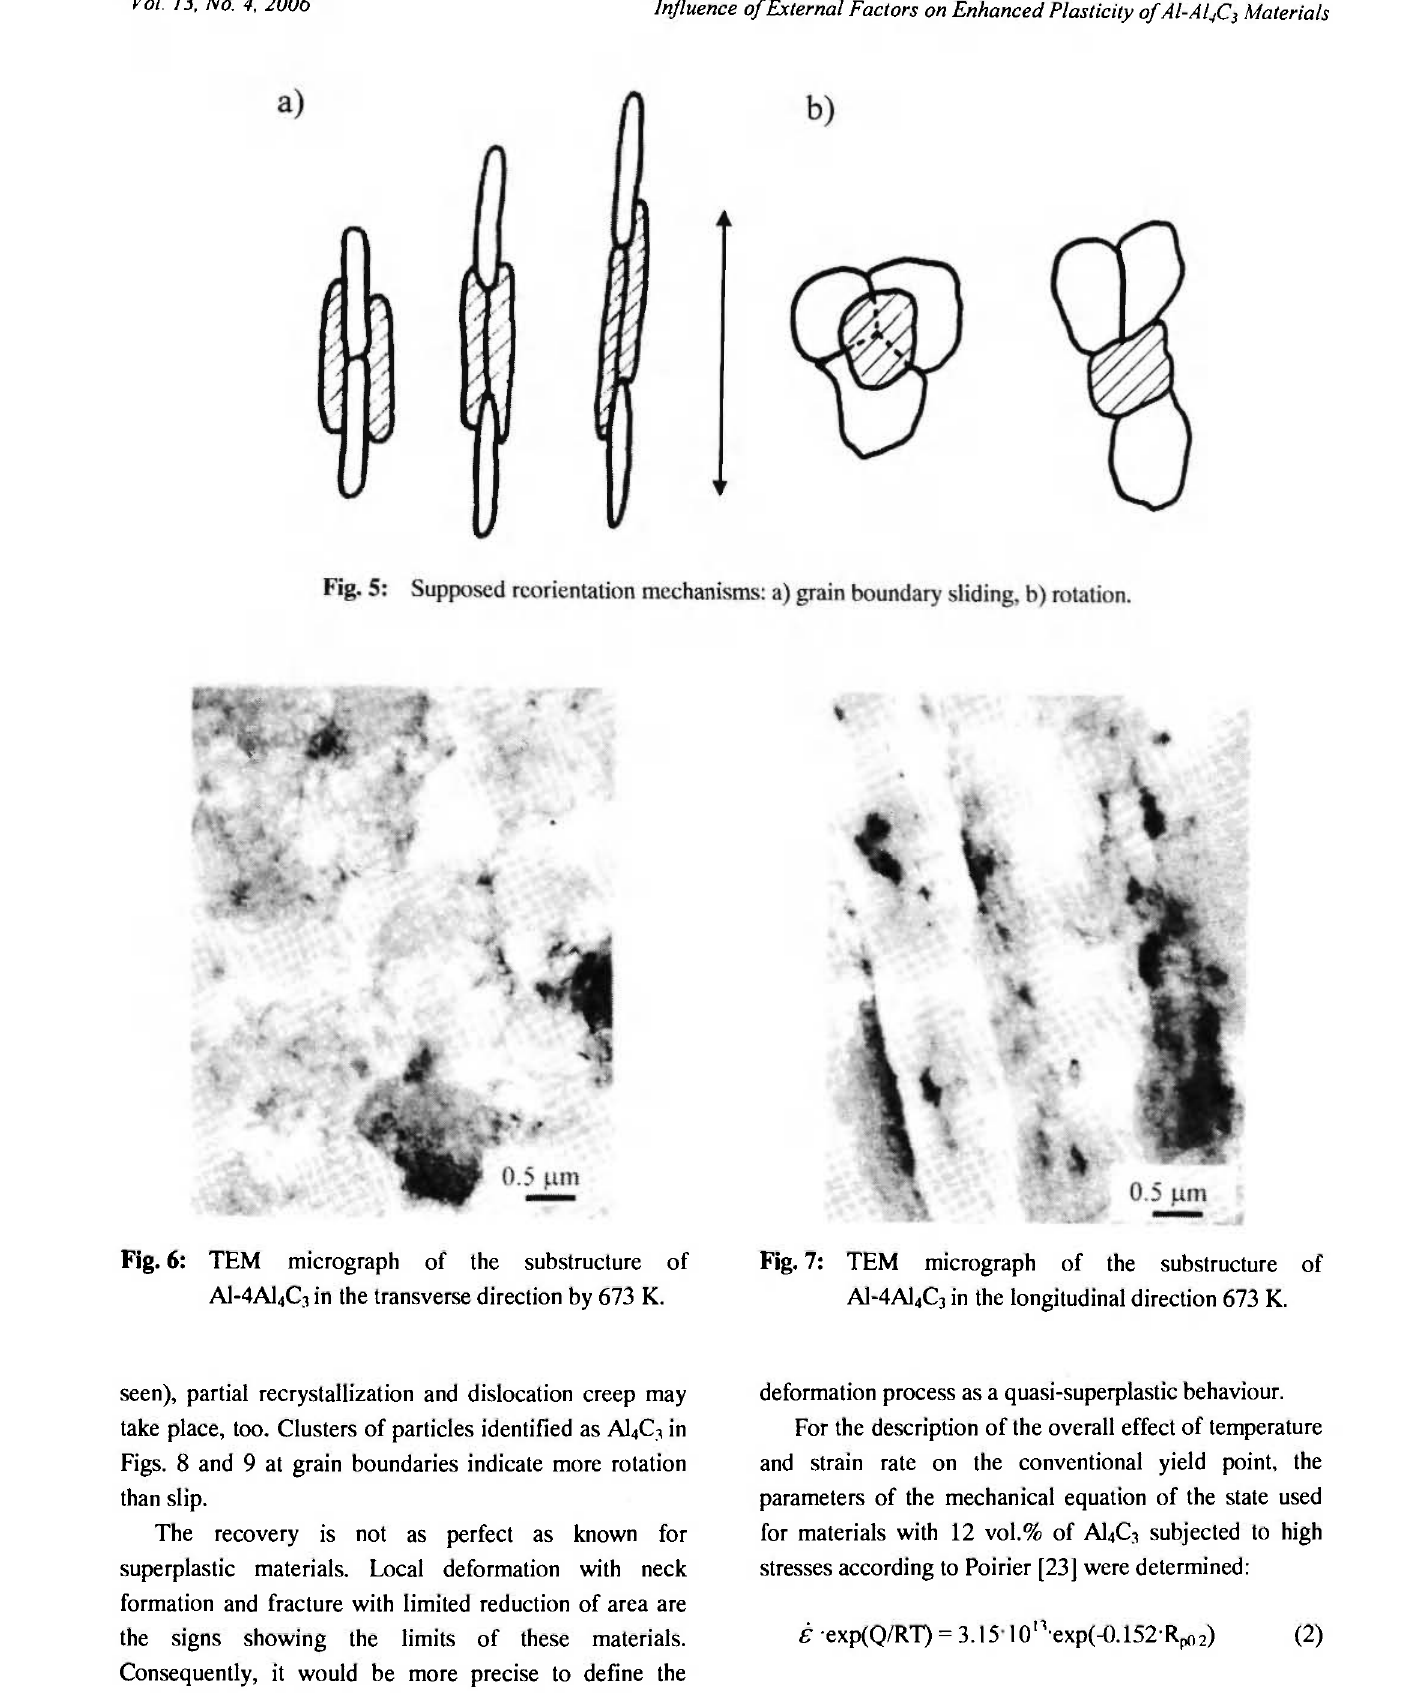
Fig. 7: TEM micrograph of the substructure of AMAI4C3 in the longitudinal direction 673